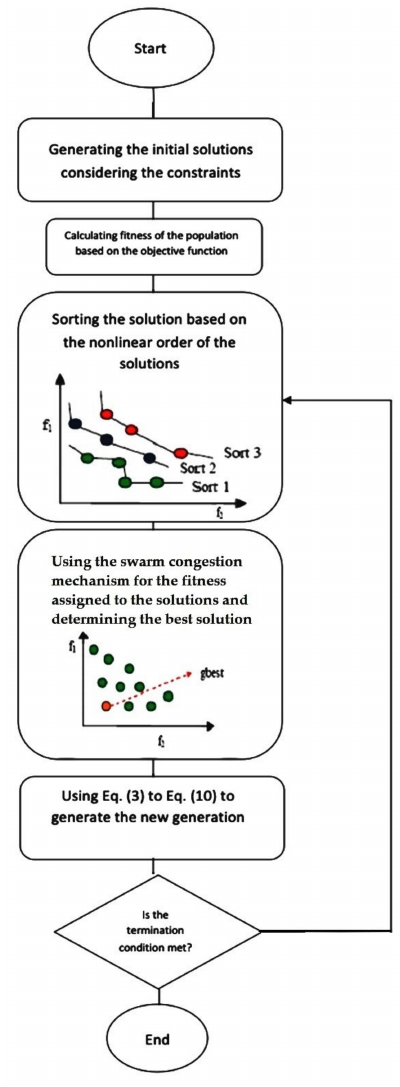
Figure 2. Flowchart of the proposed